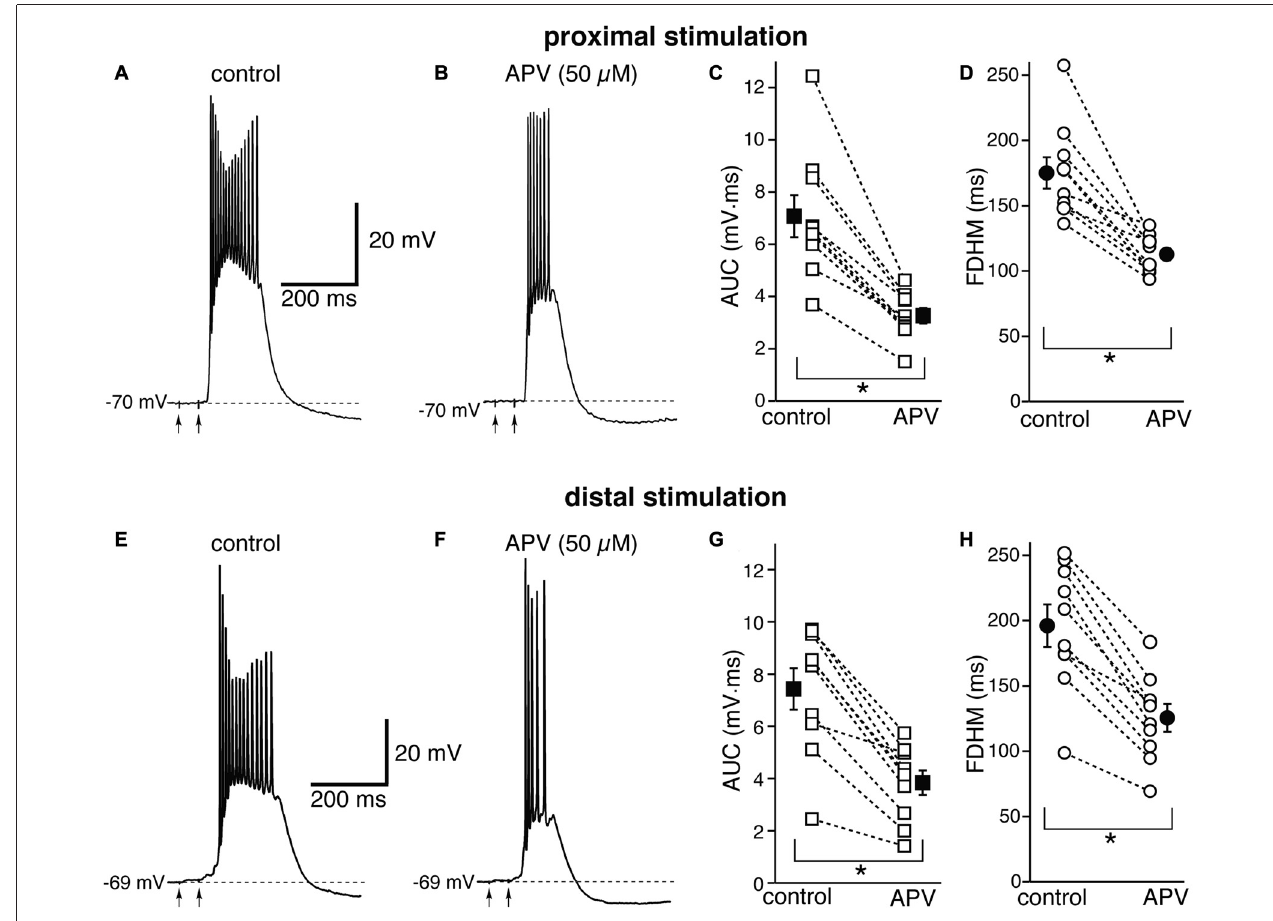
FIGURE 3 | The glutamatergic NMDA receptor antagonist D,L-2-amino-5-phosphonovaleric acid (APV) reduces the duration and area of the bursts by a similar proportion in EC layer V neurons, at both proximal and distal locations. Top, representative trace of a burst recorded upon stimulation of proximal afferent fibers in control conditions (A) and in the presence of APV (50 µ M, B ). The arrows indicate the timing of the electrical stimulation. APV reduced the AUC (C) by 53 ± 3% and the FDHM (D) by 34 ± 4% in n = 10 neurons. Bottom, representative trace of a burst recorded upon stimulation of distal afferent fibers in control conditions (E) and in the presence of APV (50 µ M, F ). APV reduced the AUC (G) by 48 ± 4%, and the FDHM (H) by 36 ± 2% in n = 10 neurons. Asterisks indicate significant difference between control and APV treatment. There was no statistically significant interaction between the APV treatment and location (two-way mixed ANOVA). The traces in (A,B) and (E,F) were recorded from two separate